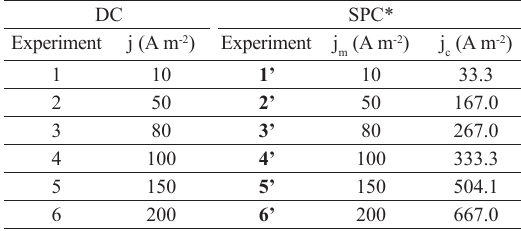
Table 2. Conditions used to produce the electrodeposited Cu-Sn coatings using DC and SPC